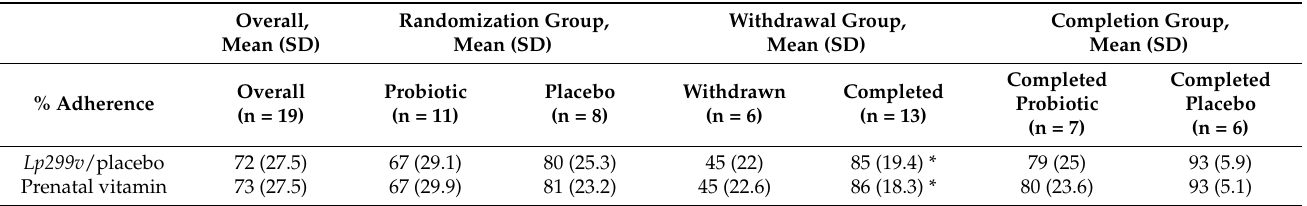
Table 3. Percent adherence for Lp299v /placebo and prenatal vitamin overall and by